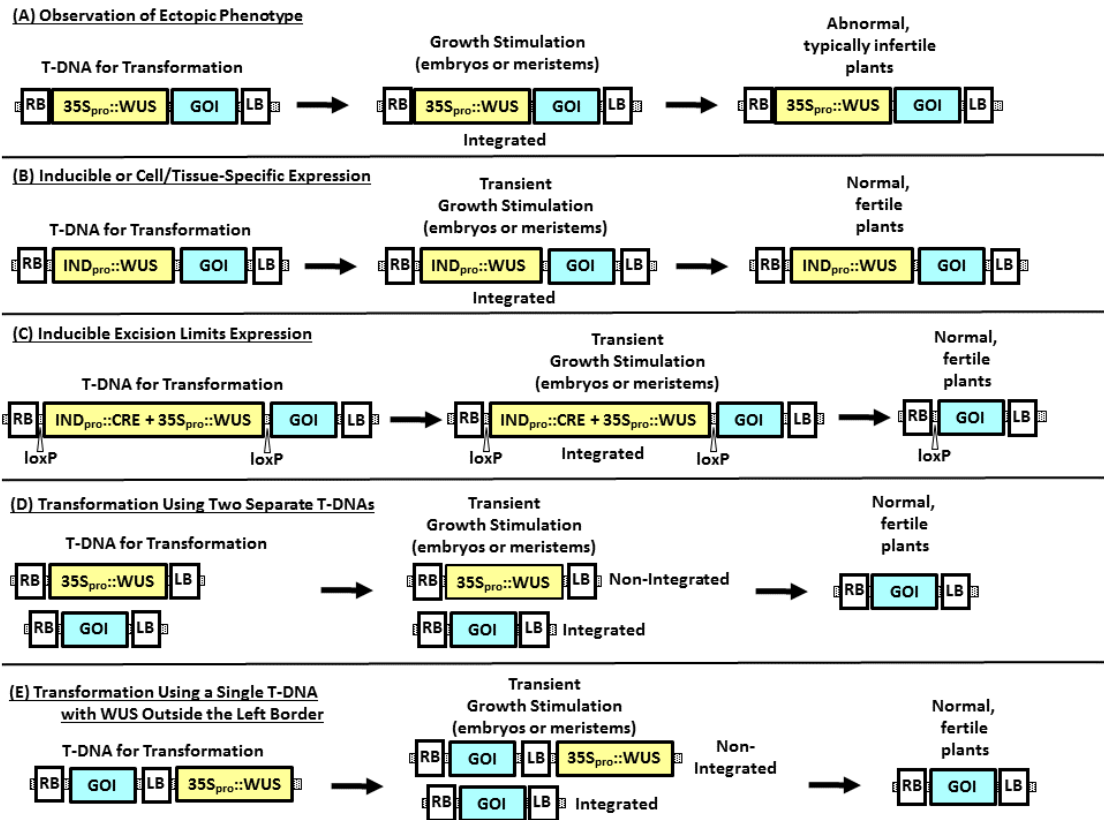
Figure 1. Methods for expression of morphogenic genes in plant transformation. WUS is used to exemplify the morphogenic gene expression cassettes, which could be designed for overexpression of the gene, downregulation of a gene, or combinations of genes, while the box labeled “GOI” (Genes Of Interest) represents trait gene expression cassettes. ( A ) Using a constitutive promoter, such as CaMV35S, to drive expression of a WUS gene results in growth stimulation of cells transformed with the T-DNA, either through somatic embryogenesis or through meristem proliferation. ( B ) Using an inducible promoter to drive expression of WUS will result in growth stimulation only when the plant tissue is exposed to the inducing stimulus (typically a chemical ligand). ( C ) Growth stimulation can also be effectively controlled by using a combination of constitutive expression of WUS and inducible expression of CRE recombinase to remove the WUS expression cassette. ( D ) Transforming the same plant cell with a T-DNA containing the WUS expression cassette and a second T-DNA containing the trait expression cassette will also provide transient growth stimulation sufficient to recover regenerable tissues, such as somatic embryos, without the integration of the morphogenic gene. ( E ) Using a single T-DNA containing the trait, with the WUS expression cassette outside the T-DNA Left Border sequence, higher numbers of the trait-containing T-DNA are introduced relative to the low numbers of “read-through” sequences containing the WUS gene, providing transient growth stimulation without WUS integration. IND pro is used to represent chemically inducible promoters, such as the estradiol-, glucocorticoid-, or tetracycline-responsive promoters in 1-B. Promoters that are induced by physical conditions, such as desiccation (e.g., the RAB17 promoter in [17]), are used to control recombinase-mediated excision (as in 1-C). CRE represents the CRE recombinase expression cassette and loxP are the CRE-recombinase target sites. RB and LB represent the right and left T-DNA border sequences, respectively.